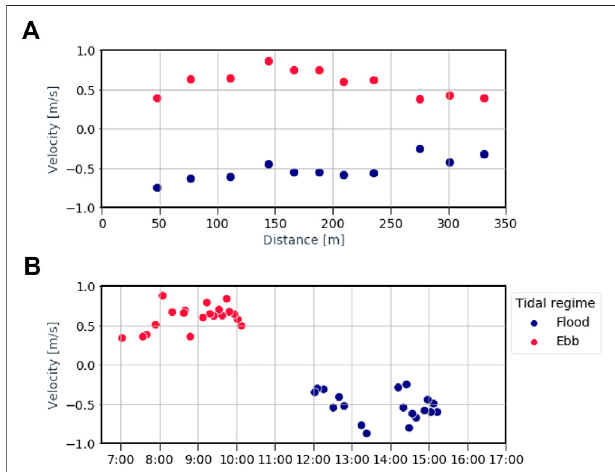
FIGURE 10 | Stream fl ow velocity of the Saigon river close to Thu Thiem bridge. (A) Average fl ow velocity along the river width (distance from the northern river bank) (B) Flow velocity throughout the day. Negative values indicate stream fl ow in fl ood tidal regime, positive in ebb